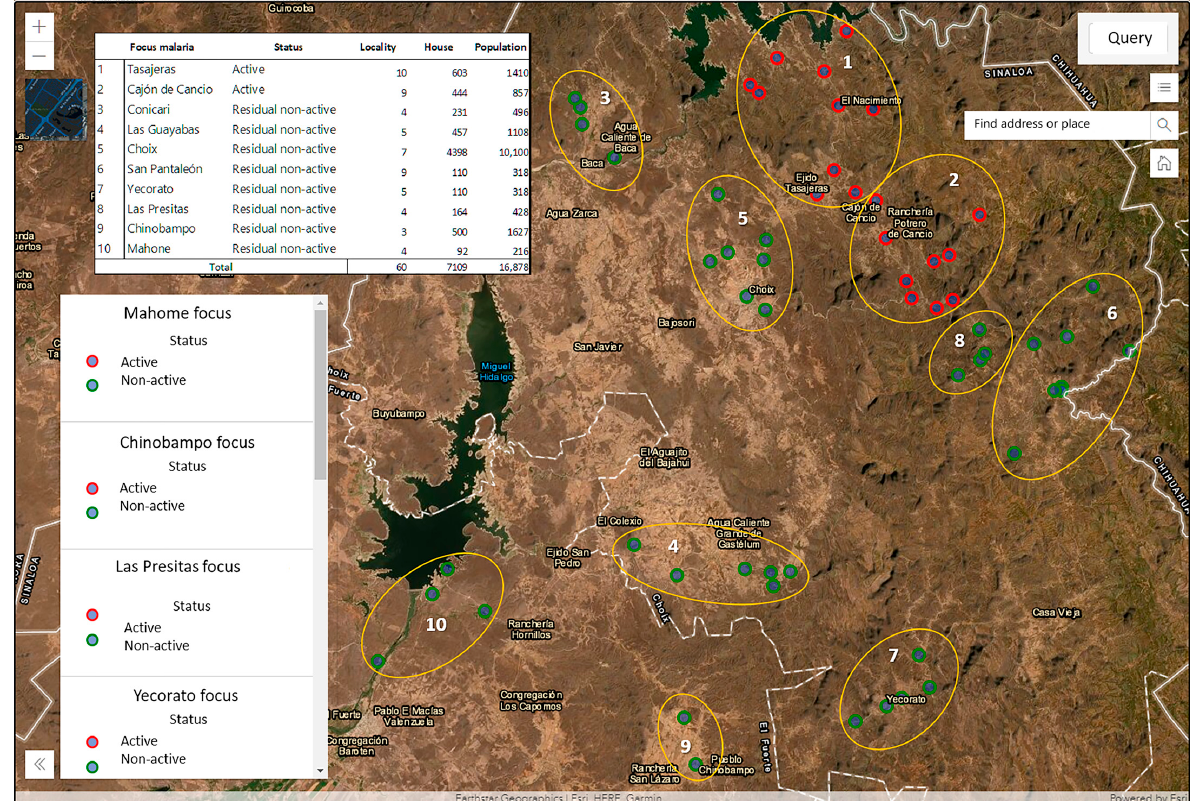
Figure 8. Geographic information system (spatial data viewer). Example of active and residual foci in the State of Sinaloa (yellow circles) identified with a consecutive number. You can see the localities where one or more autochthonous malaria cases were detected (within the last year) that were classified as active foci and the localities where malaria transmission was recently interrupted (between 1 to 3 years) that were classified as foci